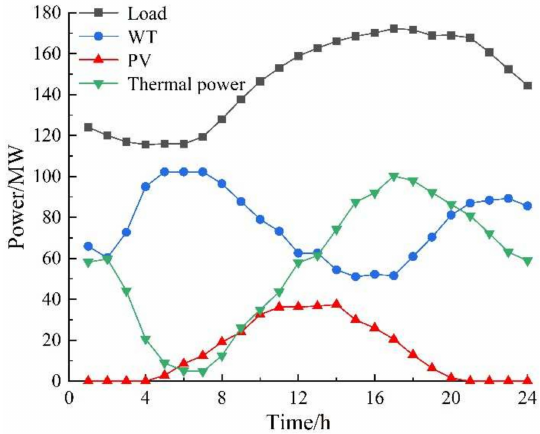
Figure 15. Typical daily power curve for scenario 2.